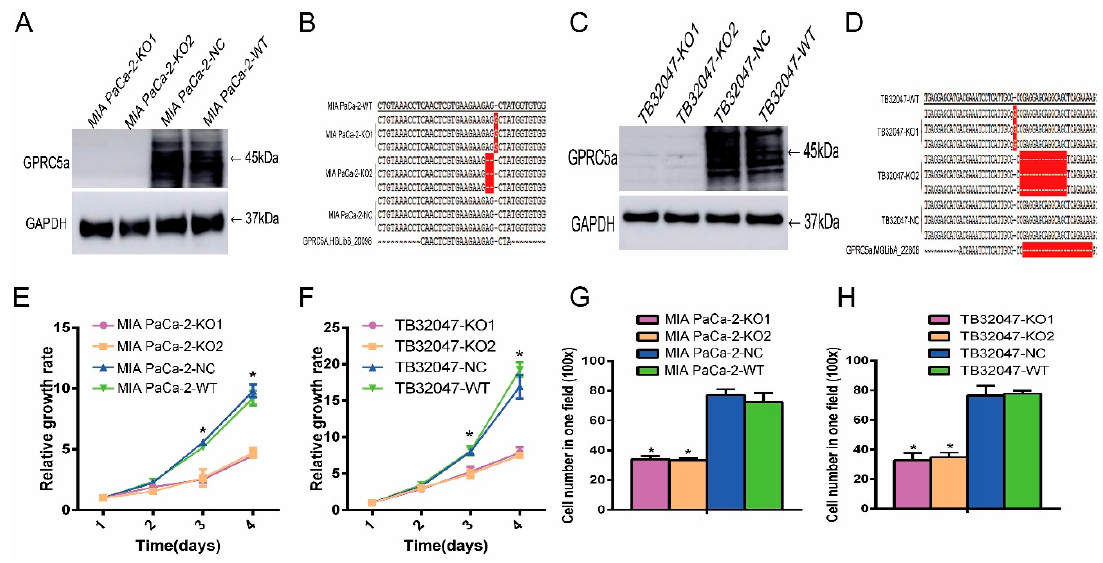
Figure 3. Influence of GPRC5a knockout on the proliferation and migration ability in MIA PaCa-2 and TB32047 cells. ( A – D ) Western blot and sequencing results showing the GPRC5a knocked out in MIA PaCa-2-KO1/2 and TB32047-KO1/2 (Red highlight area means the different part in comparison of sequencing sequence). ( E , F ): The knockout of GPRC5a inhibited the proliferation ability of MIA PaCa-2 and TB32047 cells. ( G , H ) GPRC5a knockout inhibited the migration ability of MIA PaCa-2 ( G ) and TB32047 cells ( H ). * p -value < 0.05.